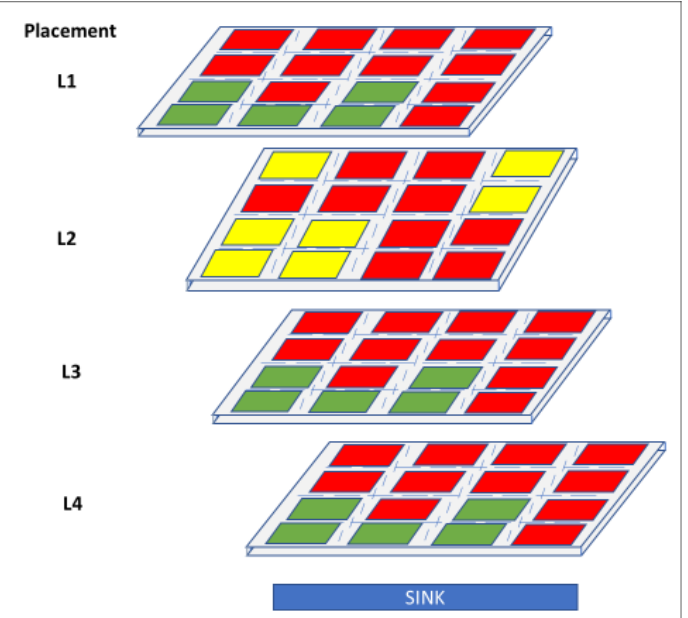
Figure 7. Placement of LLC banks (yellow), GPUs (red), and CPUs (green) as a result of the proposed MOO method [6].